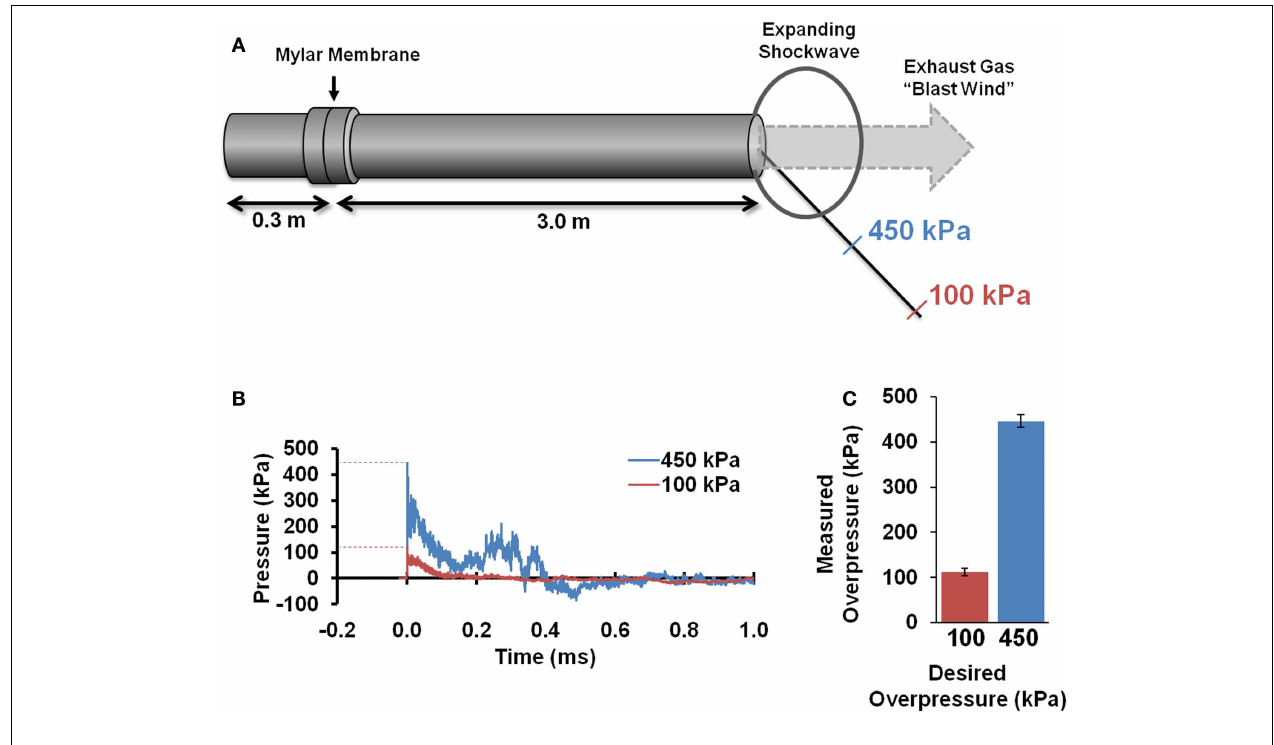
the typical reflected pressures (B) experienced during the blast shockwave. Blast peak overpressures realized during actual exposures to the rat head (C) were highly accurate and reproducible ( n = 8 for